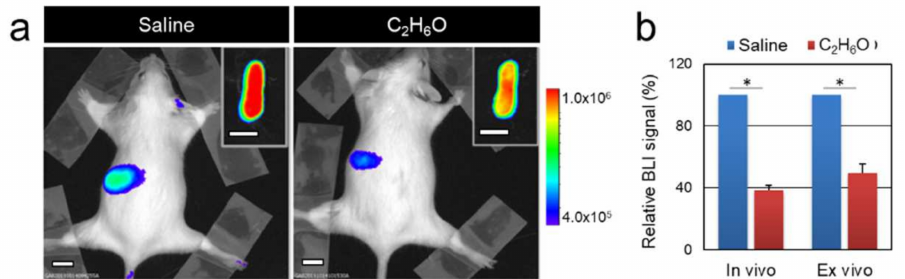
Figure 1. Response of NF-Y-dependent cell proliferation to acute ethanol administration in the MITO- Luc mouse model. ( a ) Bioluminescence imaging analysis performed on a representative animal 5 days after administration of saline or C 2 H 6 O solution. The insets show ex vivo imaging of excised spleens. ( b ) Regions of interests were drawn around spleens and quantified BLI intensities relative to saline control levels are shown in the graph. White scale bars: 1 cm. The pseudo-color scale bar represents the relative bioluminescent signal intensities from the lowest (blue) to the highest (red); radiance is expressed in photons per second per square centimeter per steradian (photons/s/cm 2 /sr). The asterisk (*) indicates a statistically significant difference between the indicated groups ( p ≤